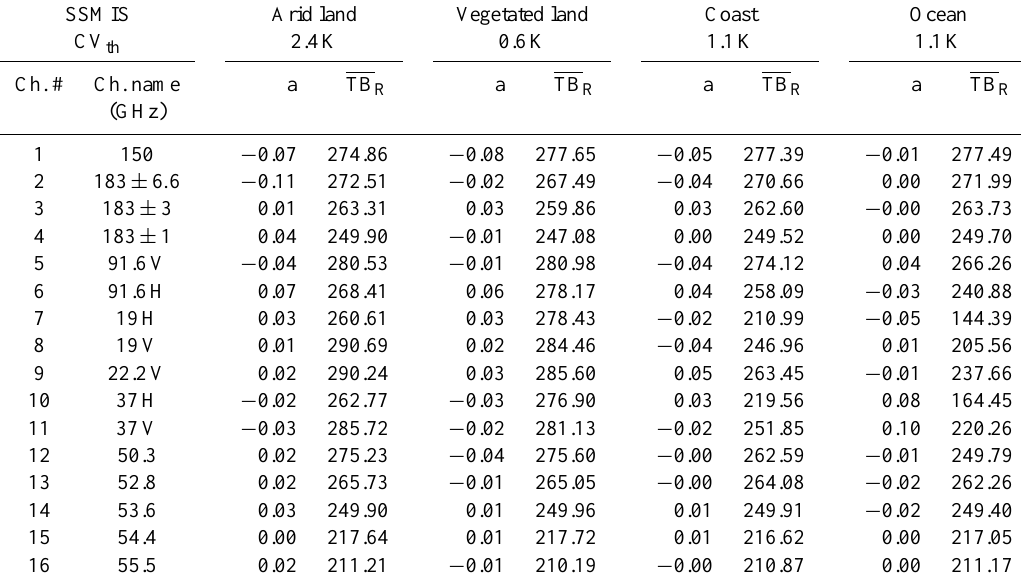
Table A1. List of CCA coefficients and CVth thresholds used by the CCA algorithms for the SSMIS radiometer.